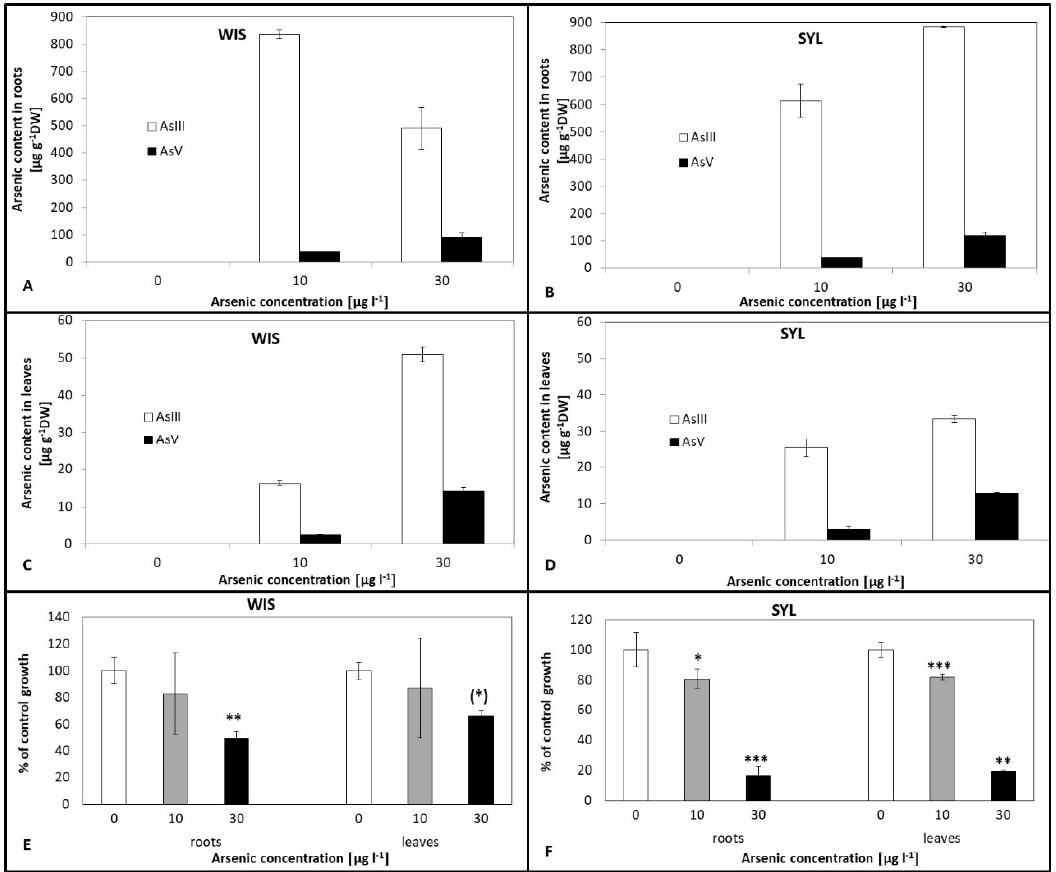
Figure 1. Arsenic contents and the growth response to arsenic treatments in two contrasting tobacco genotypes. ( A , C, and E ) Tolerant N.t. cv. Wisconsin; ( B , D , and F ) Sensitive N. sylvestris . 0, 10, and 30 µg l -1 arsenate concentrations. Bars indicate standard deviations. Stars mean statistically significant differences from the control at the level α = 0.1 ((*)), 0.05(*), 0.01 (**), 0.001(***), n = 5.